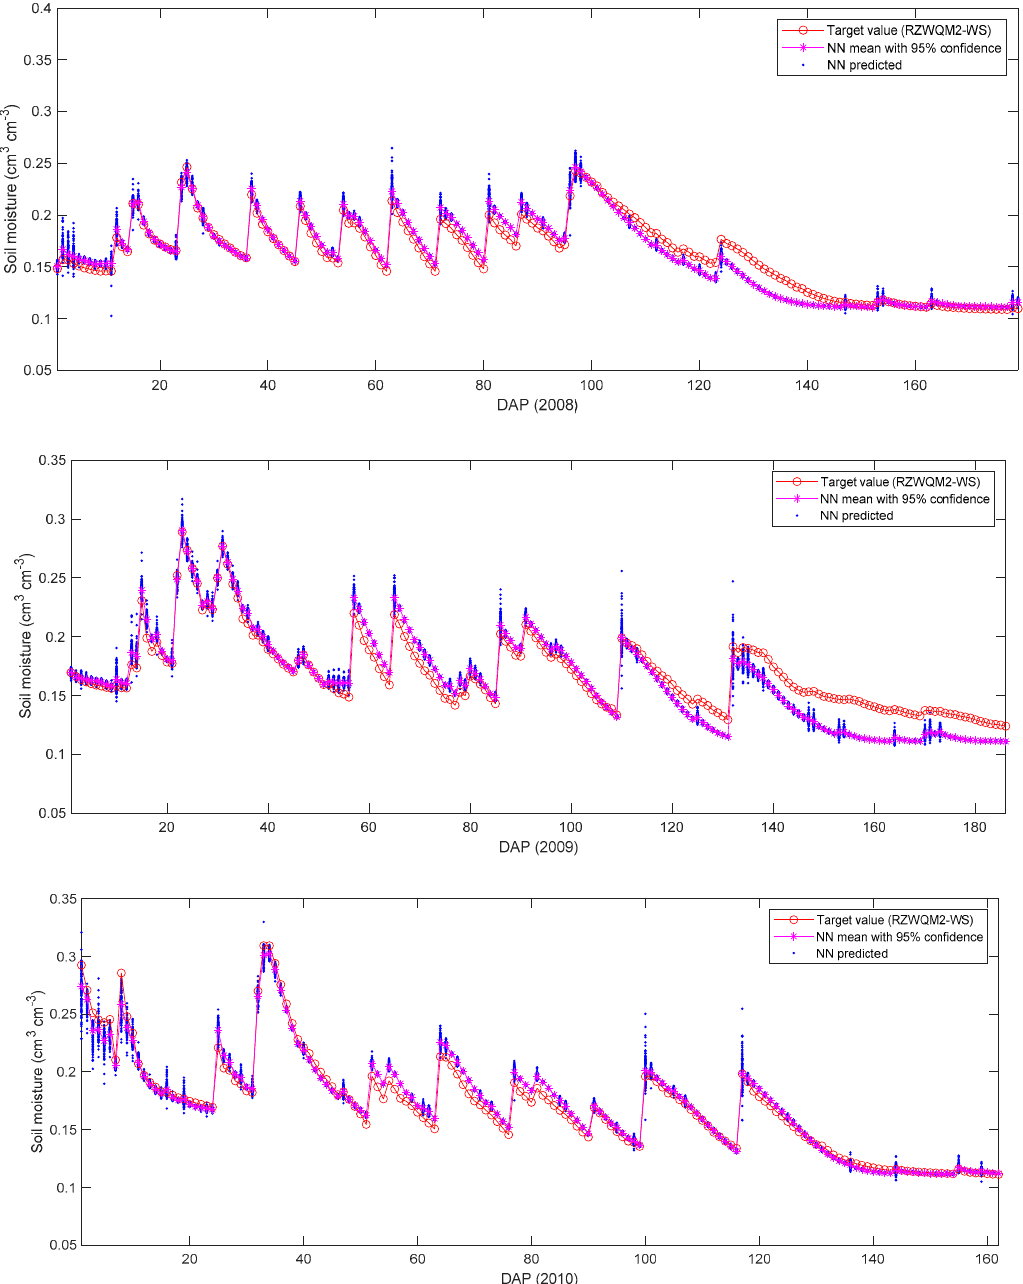
Figure 6. Predicted soil moistures across the root zone of 100 neural network (NN) models with random initial model parameters and given initial soil moisture values, and their daily averages against the target values. The daily average soil moisture was calculated using the 100 NN model results with 95% confidence. Each NN model predicted daily soil moisture based on the hesternal average value. DAP is day after plant, RZWQM2-WS represents the water stress (WS) method with RZWQM2 simulations.